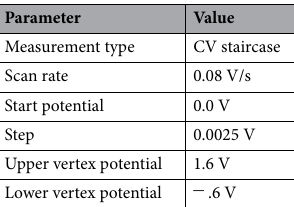
Table 3. Parameters of cyclic voltammetry measurement